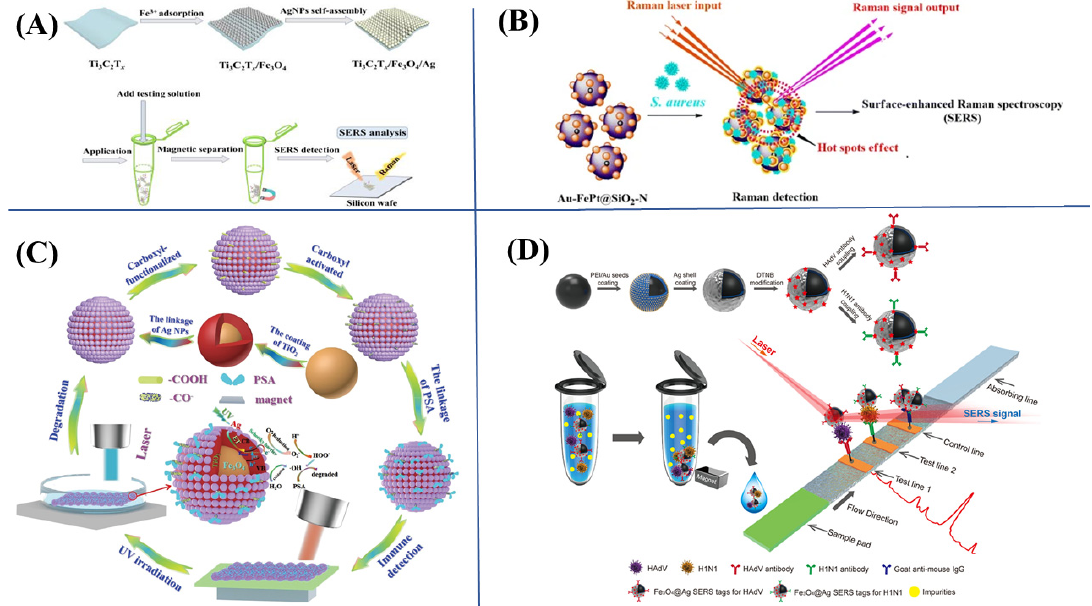
Figure 4. ( A ) Rapid SERS quantification for multiple trace sulfonamides in aquatic products